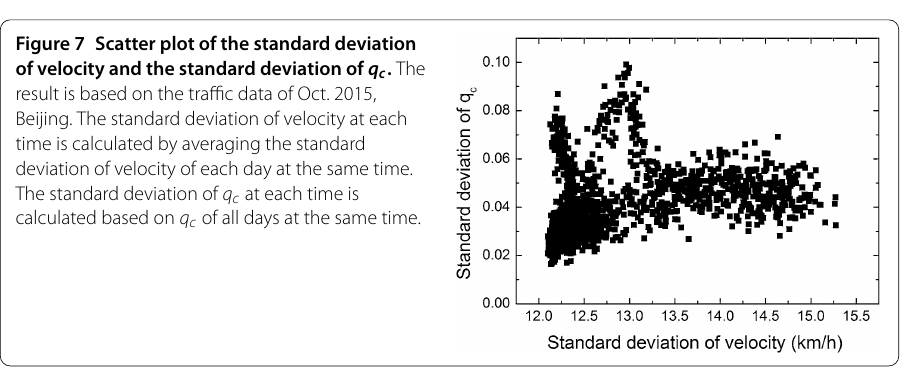
Figure 6 The probability distribution of different indices values during morning peak in workdays . (a) The probability distribution of different indices values during morning peak in workdays in Beijing. (b) The probability distribution of different indices values during morning peak in workdays in Shenzhen.